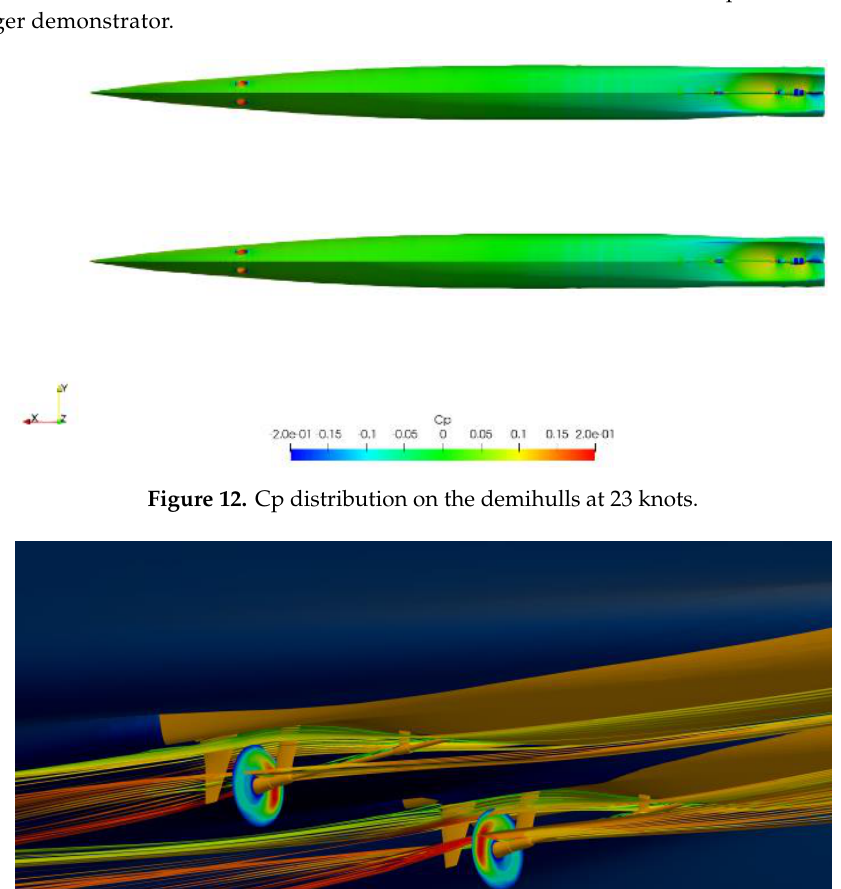
Figure 12. Cp distribution on the demihulls at 23 knots.